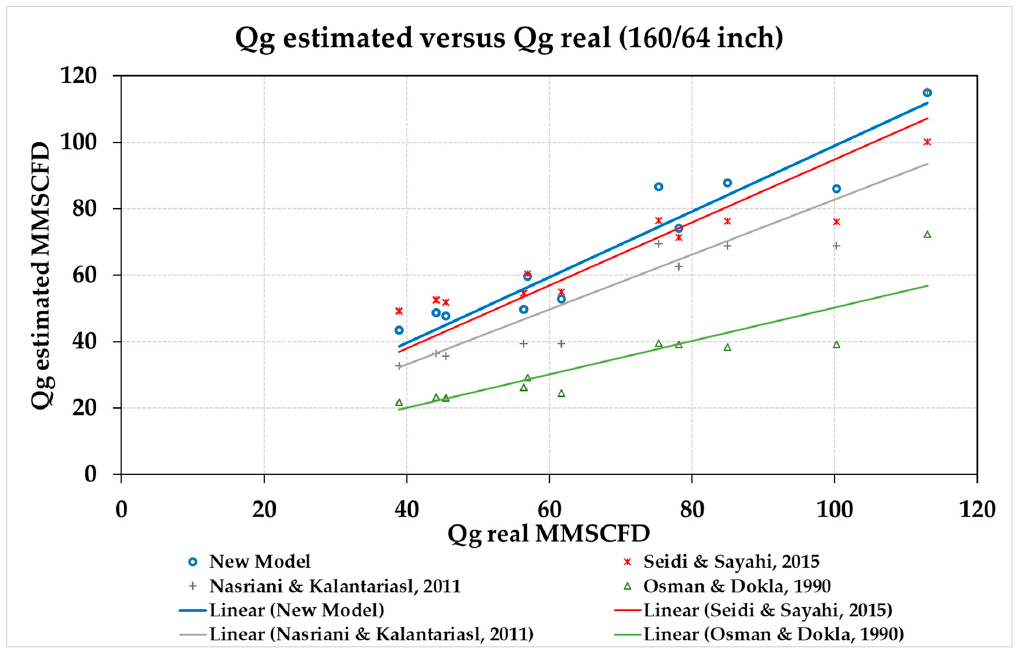
Figure 10 . Estimated gas flow rate versus real gas flow rate (160/64 inch) .